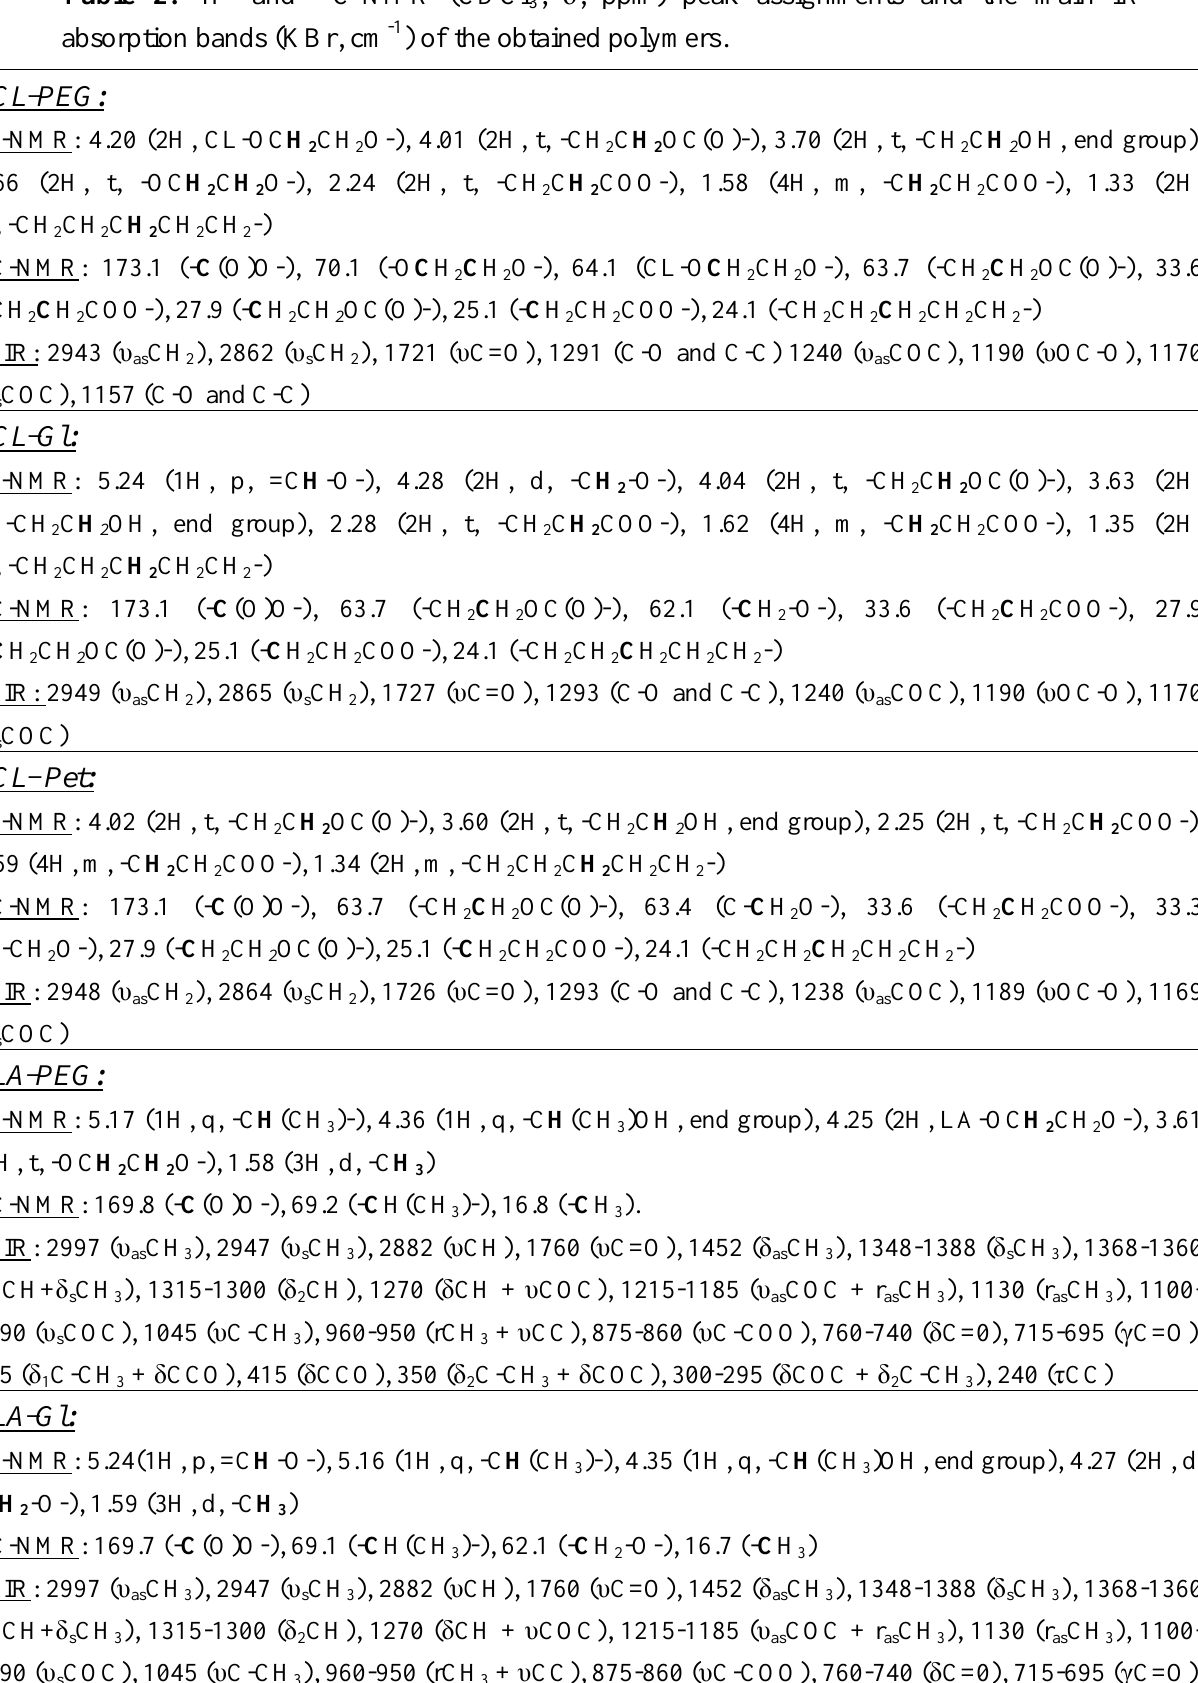
, δ , ppm) peak assignments and the main IR 3